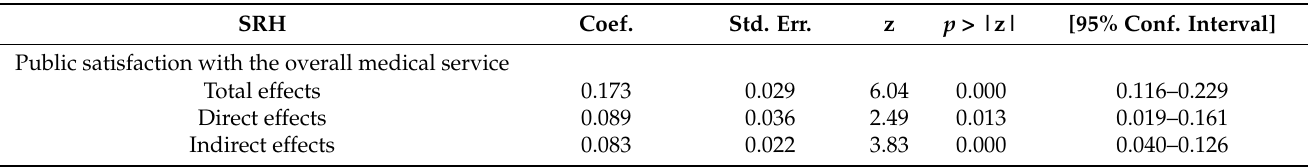
Table 3. The overall KHB mediation analysis results.